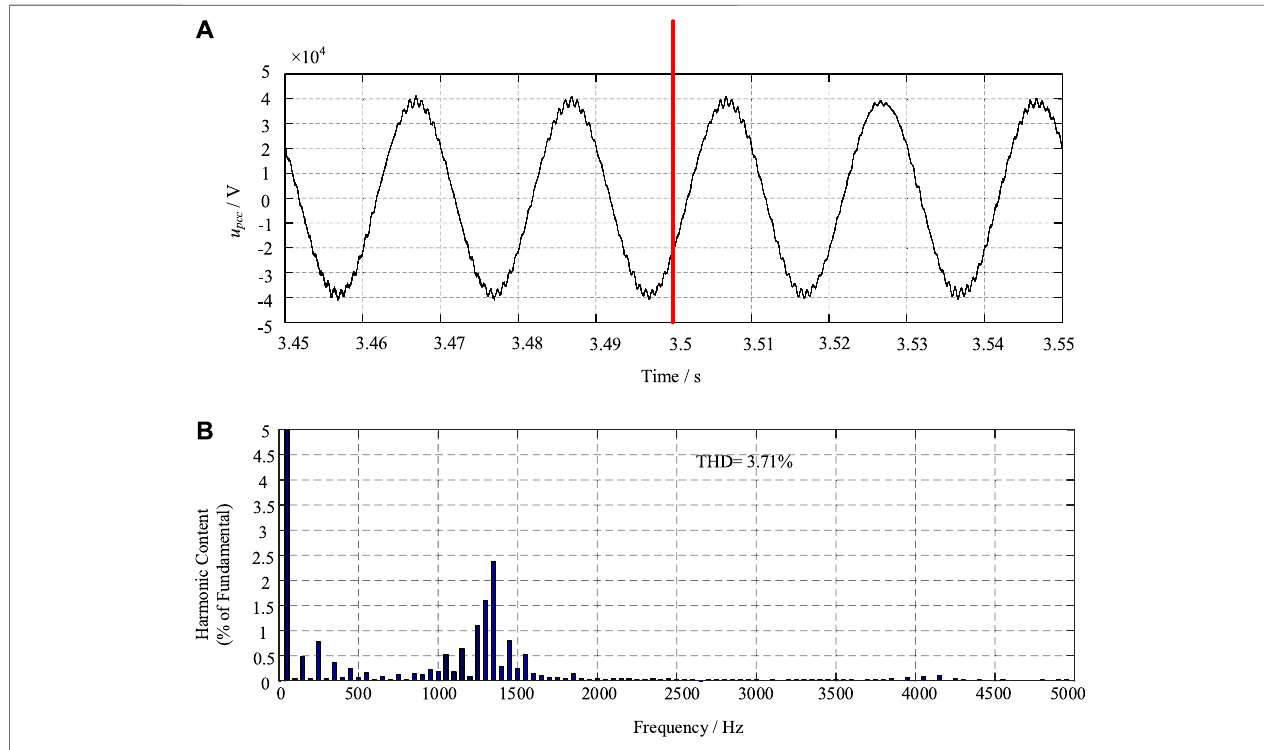
FIGURE 12 | The simulated waveforms and the harmonic spectra for case III (A) voltage of the PCC, (B) harmonic spectra of u PCC .